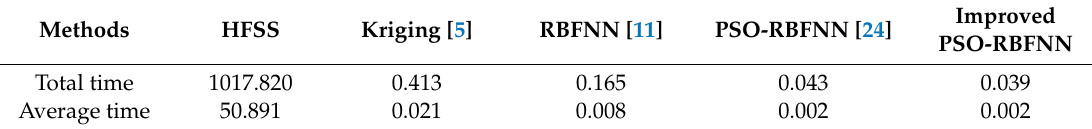
Table 2. Time cost of di ff erent surrogate models and HFSS simulations (units: